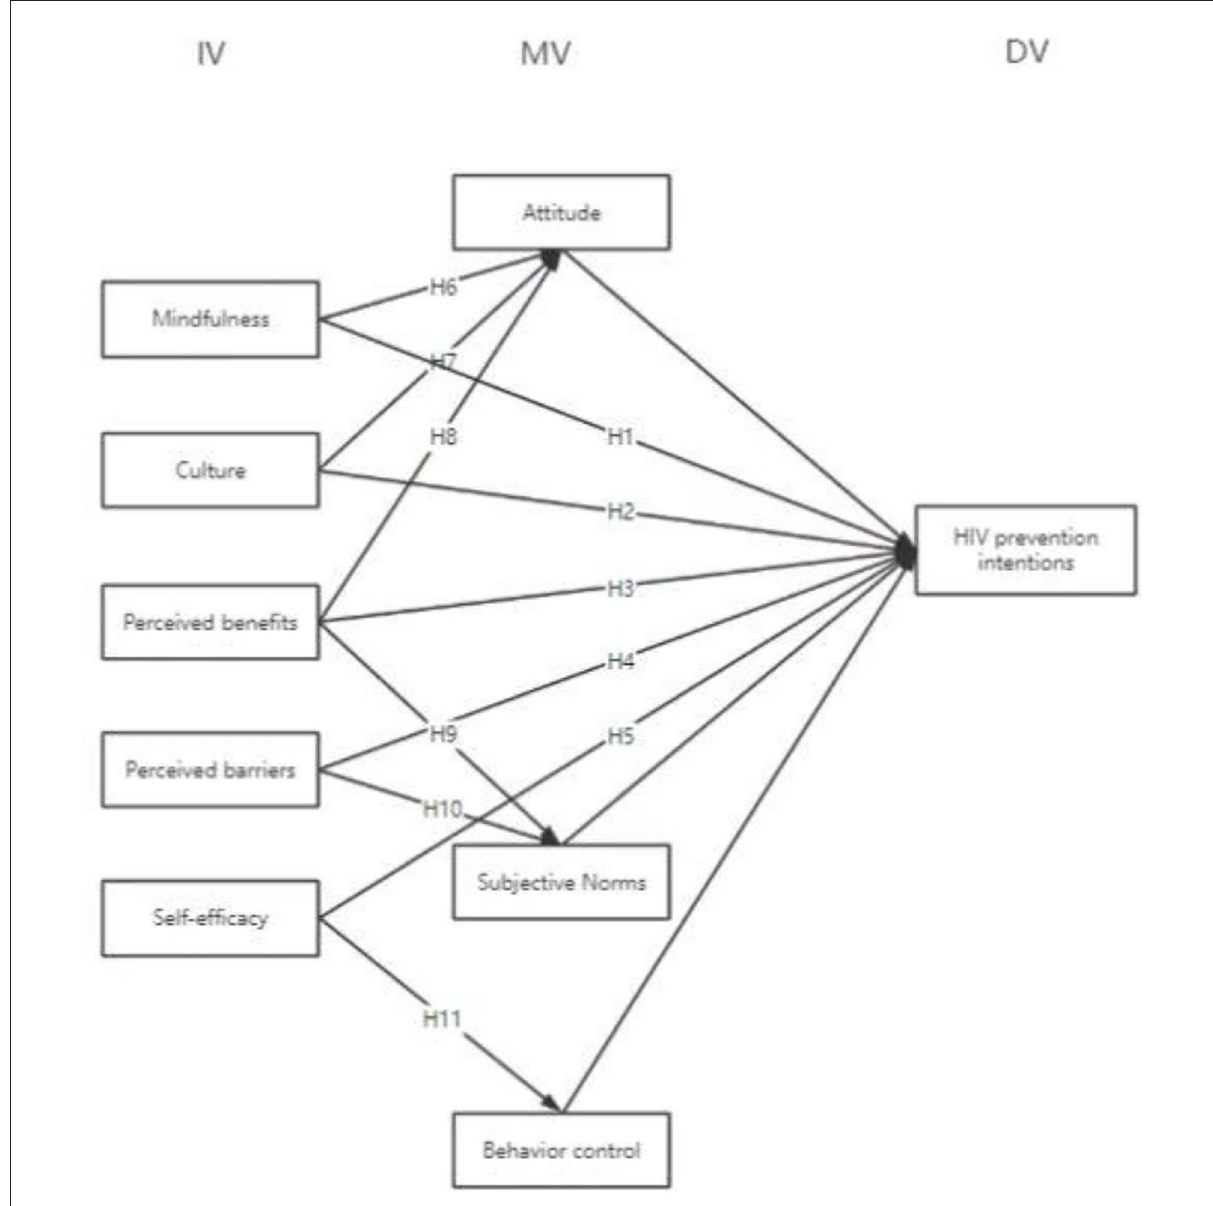
FIGURE4 Structural equation